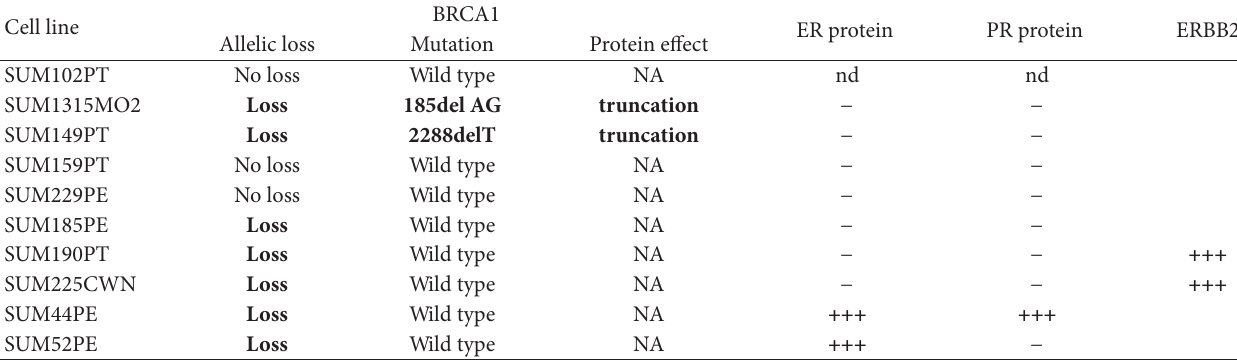
T 2: ER, PR, and BRCA1 pro�le of SUM cell